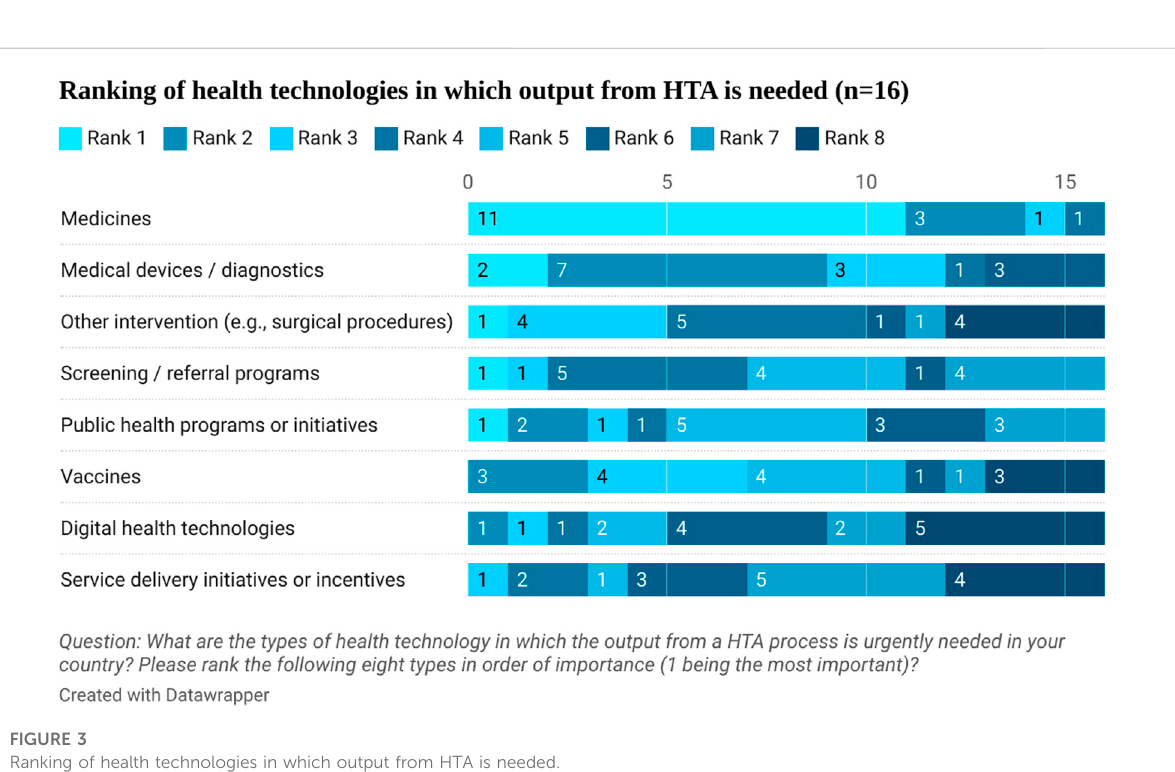
FIGURE 2 HTA-related products being developed in